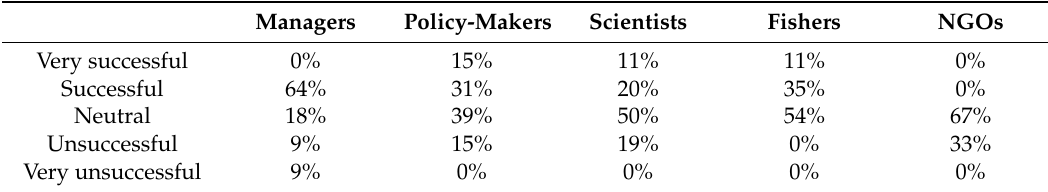
Table 1. The level of success for the implementation process of EBFM per responding group (% within each responding group. n = 108).